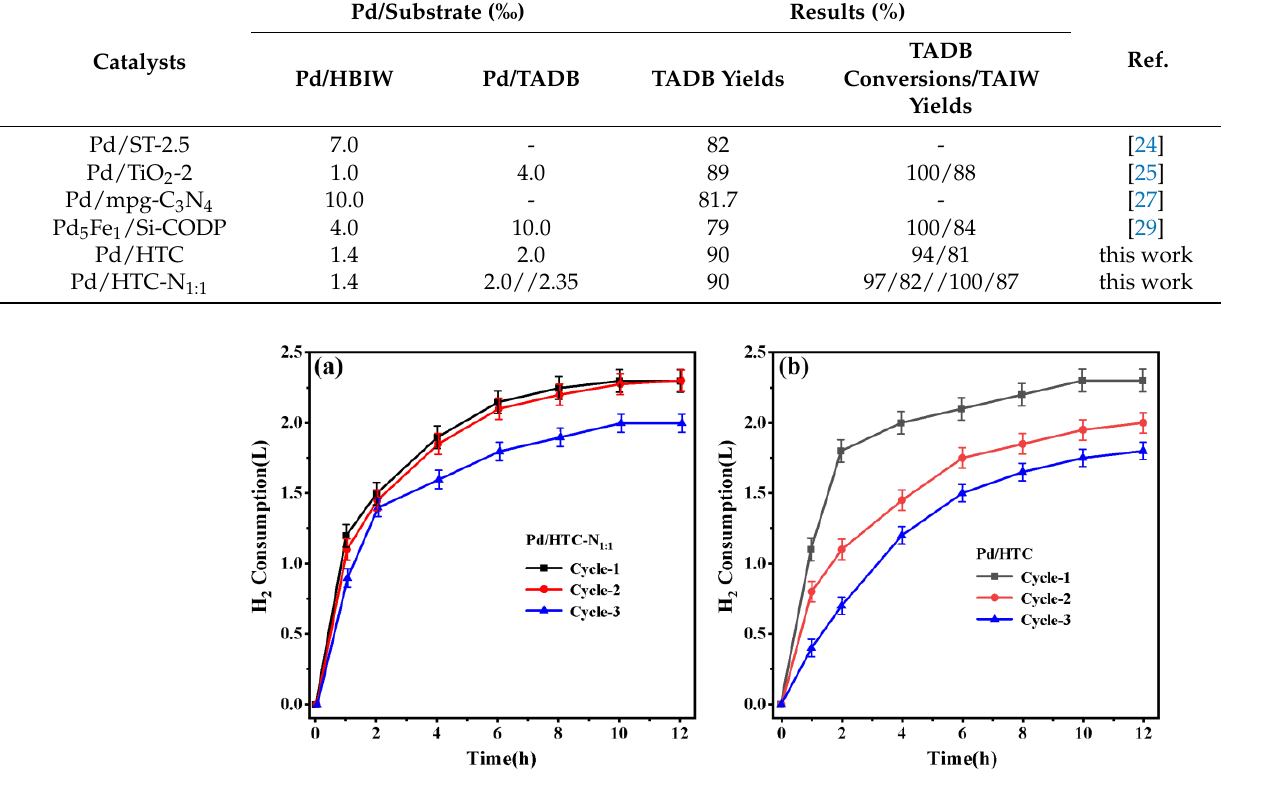
Figure 5. Hydrogen consumption amounts as functions of time during the hydrogenolysis reaction of TADB over Pd/HTC ( a ) and Pd/HTC-N 1:1 ( b ) catalysts in the cycling experiments.